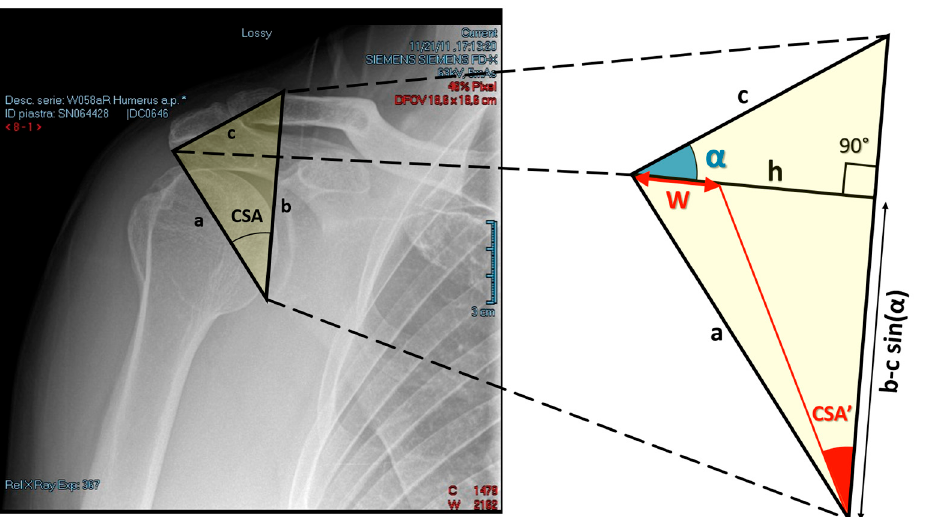
Figure 1. Geometrical derivation of the formula to estimate the amount of lateral resection, w, to obtain a desired postoperative CSA, namely CSA’. Parameters a, b, and c are the radiographic measures needed for the computation. CSA: critical shoulder angle.